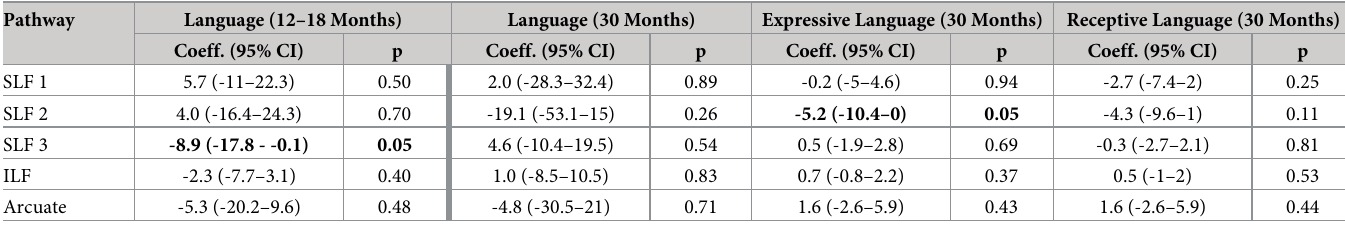
Table 6. Language outcomes and neural pathways.